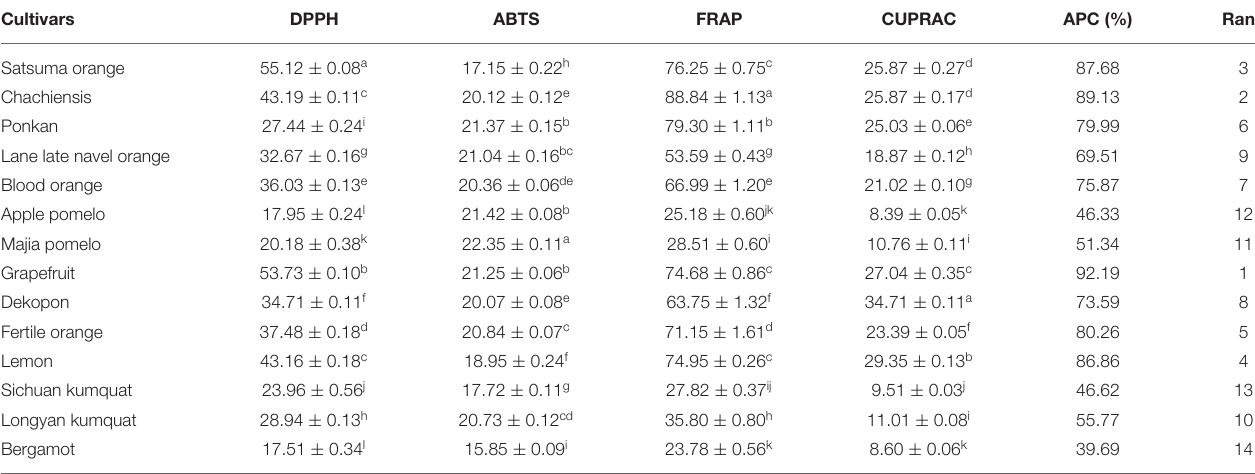
TABLE 2 | Antioxidant potency composite index of 14 CPFEs (mg TE/g DW). Cultivars DPPH ABTS FRAP Rank Satsuma